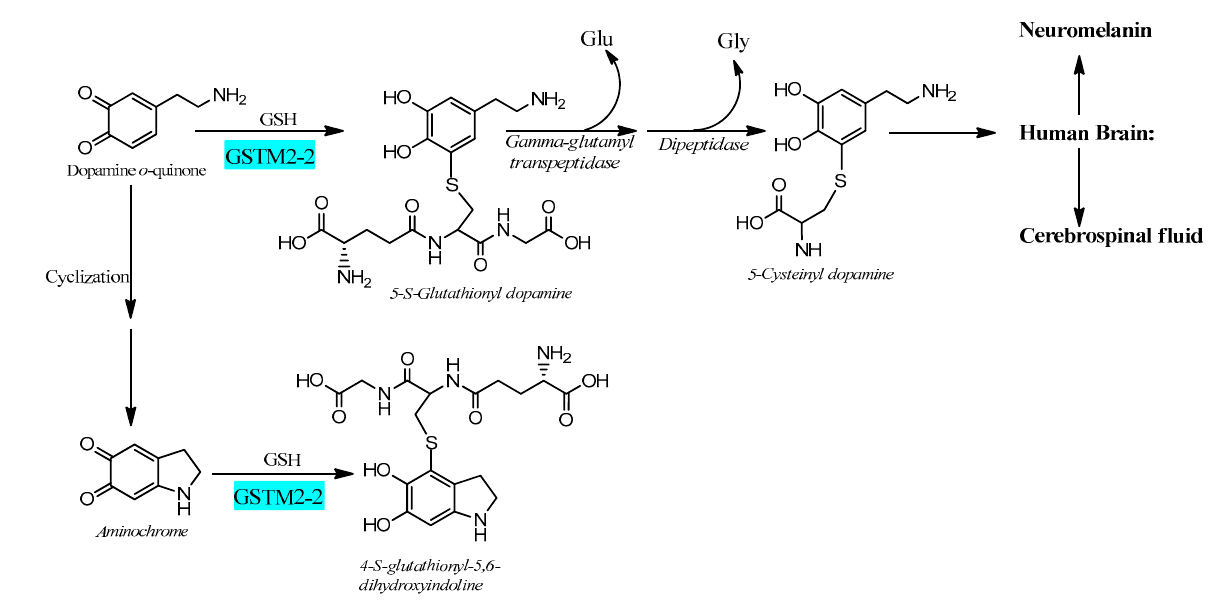
Figure 3. Glutathione transferase M2-2 catalyzes glutathione conjugation of ortho-quinones.